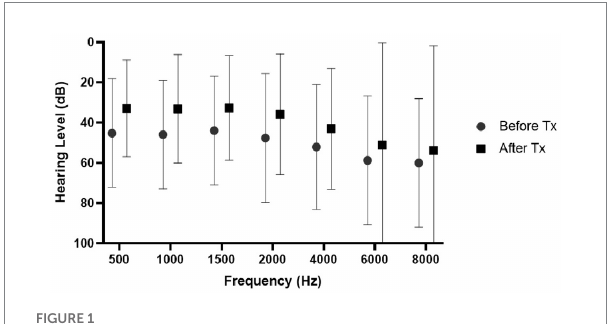
FIGURE 1 Hearing improvement following treatment according to the various frequencies of all 666 patients. Values represent mean and standard